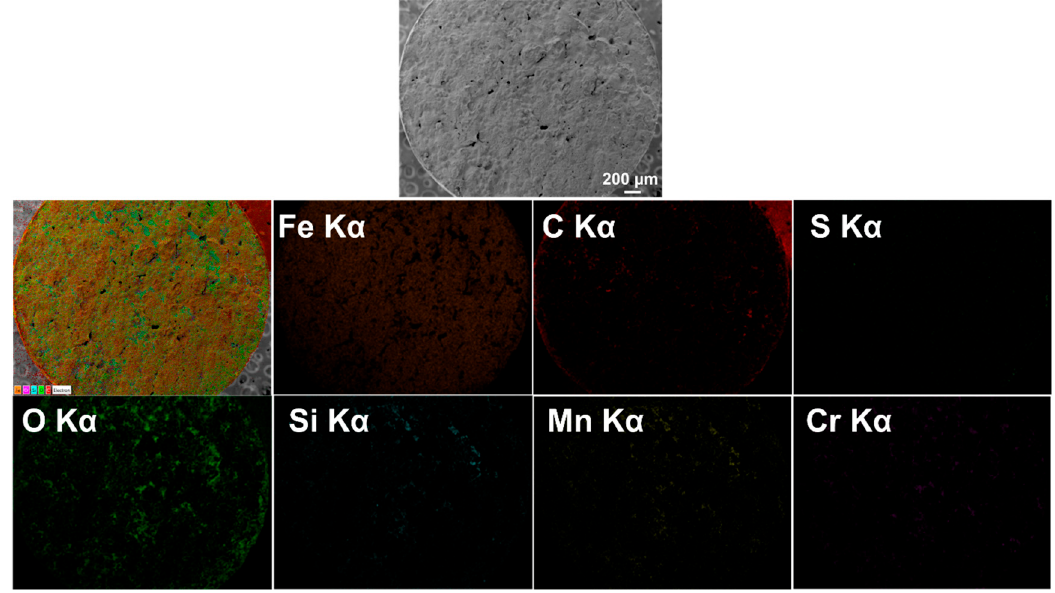
Figure 7. EDS element mapping on the fracture surface of specimen #3 from Figure 4.